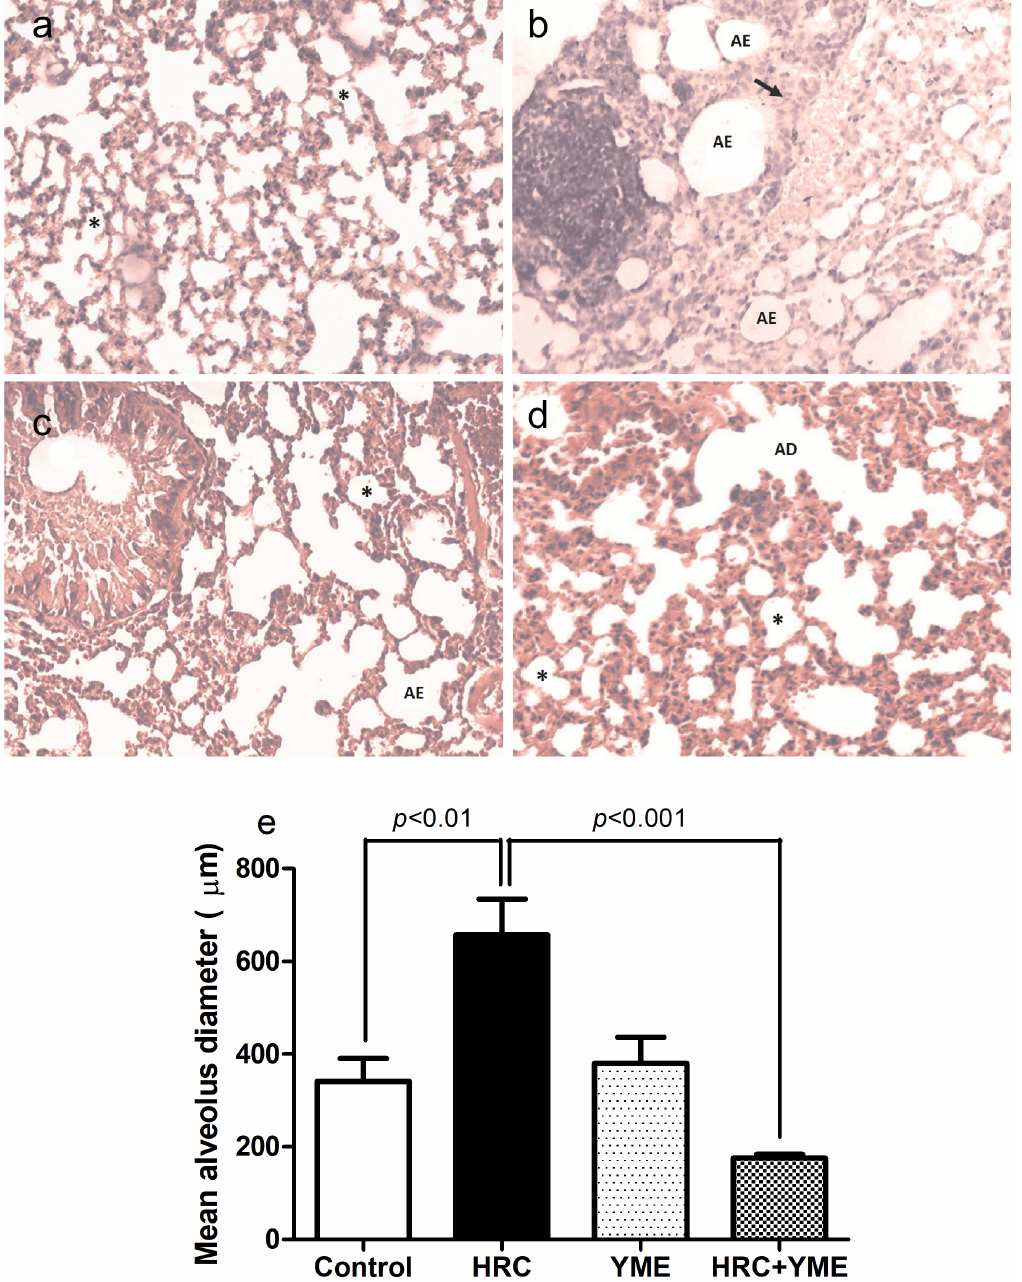
Figure 1. Pathological changes in the lung tissue of mice chronically exposed to hand-rolled cornhusk cigarette (HRC) smoke and treated with Ilex paraguariensis extract (YME). Photomicrograph of lung parenchyma areas showing respectively: (a) lung tissue exposed to ambient air showing normal alveolar ducts (back star); (b) lung parenchyma exposed to HRC, showing alveolar enlargement areas (EA) with septal thickening, presence of cellular infiltration and intense areas of atelectasis (black arrow); (c) lung tissue of mice exposed to ambient air and received YME showing normal alveolar areas (black star), septal integrity and low areas of alveolar enlargement. (d) areas of lung tissue exposed to HRC smoke and treated with YME showing presence of cellular infiltration and normal alveolar areas of the lung parenchyma (black star) with areas of intact alveolar ducts (AD) (Images: H.E, 25x objective). (e) represent represents the mean alveolar diameter in control, HRC, YME and